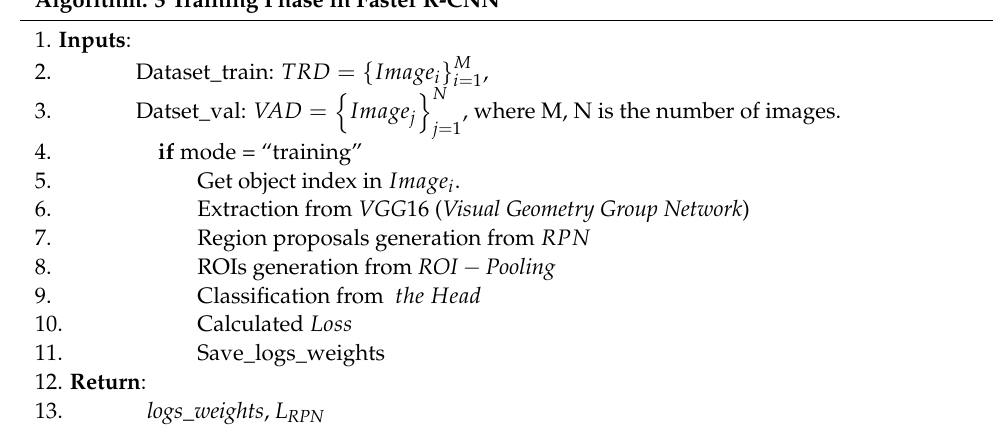
Algorithm. 3 Training Phase in Faster